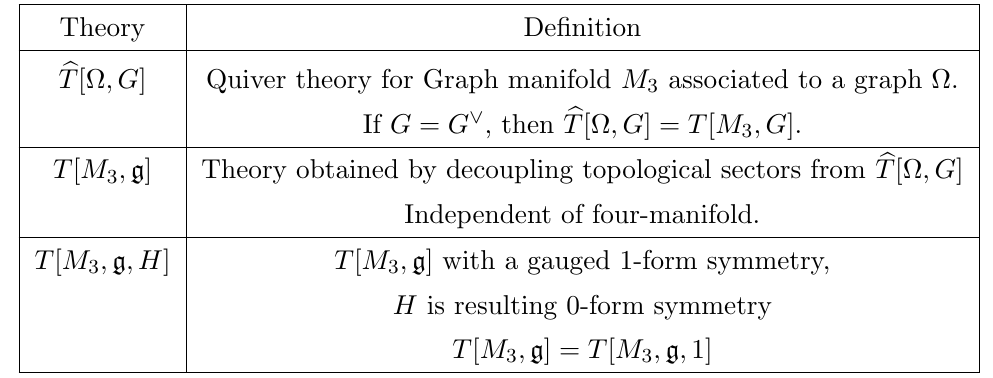
topologically 3